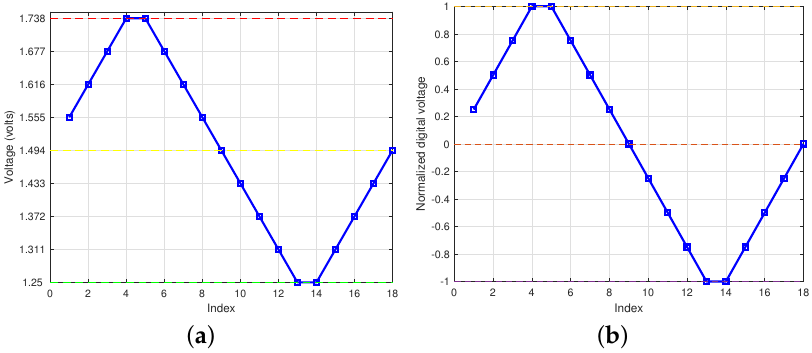
Figure 8. ( a ) Digital calibration voltages for FSM constructing models in one period. ( b ) Normalized calibration voltages for FSM constructing models in one period.